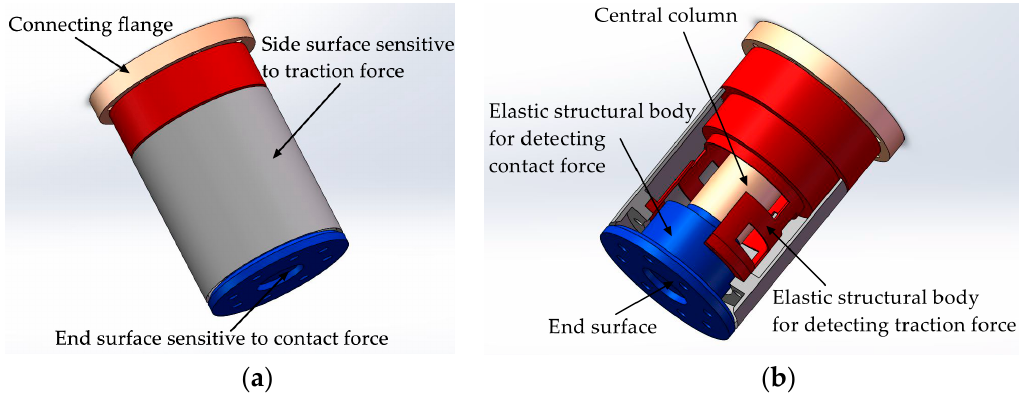
Figure 1. Schematic diagram of the ideal tandem force sensor: ( a ) structure of the ideal tandem force sensor; ( b ) the inner structure of the ideal tandem force sensor.